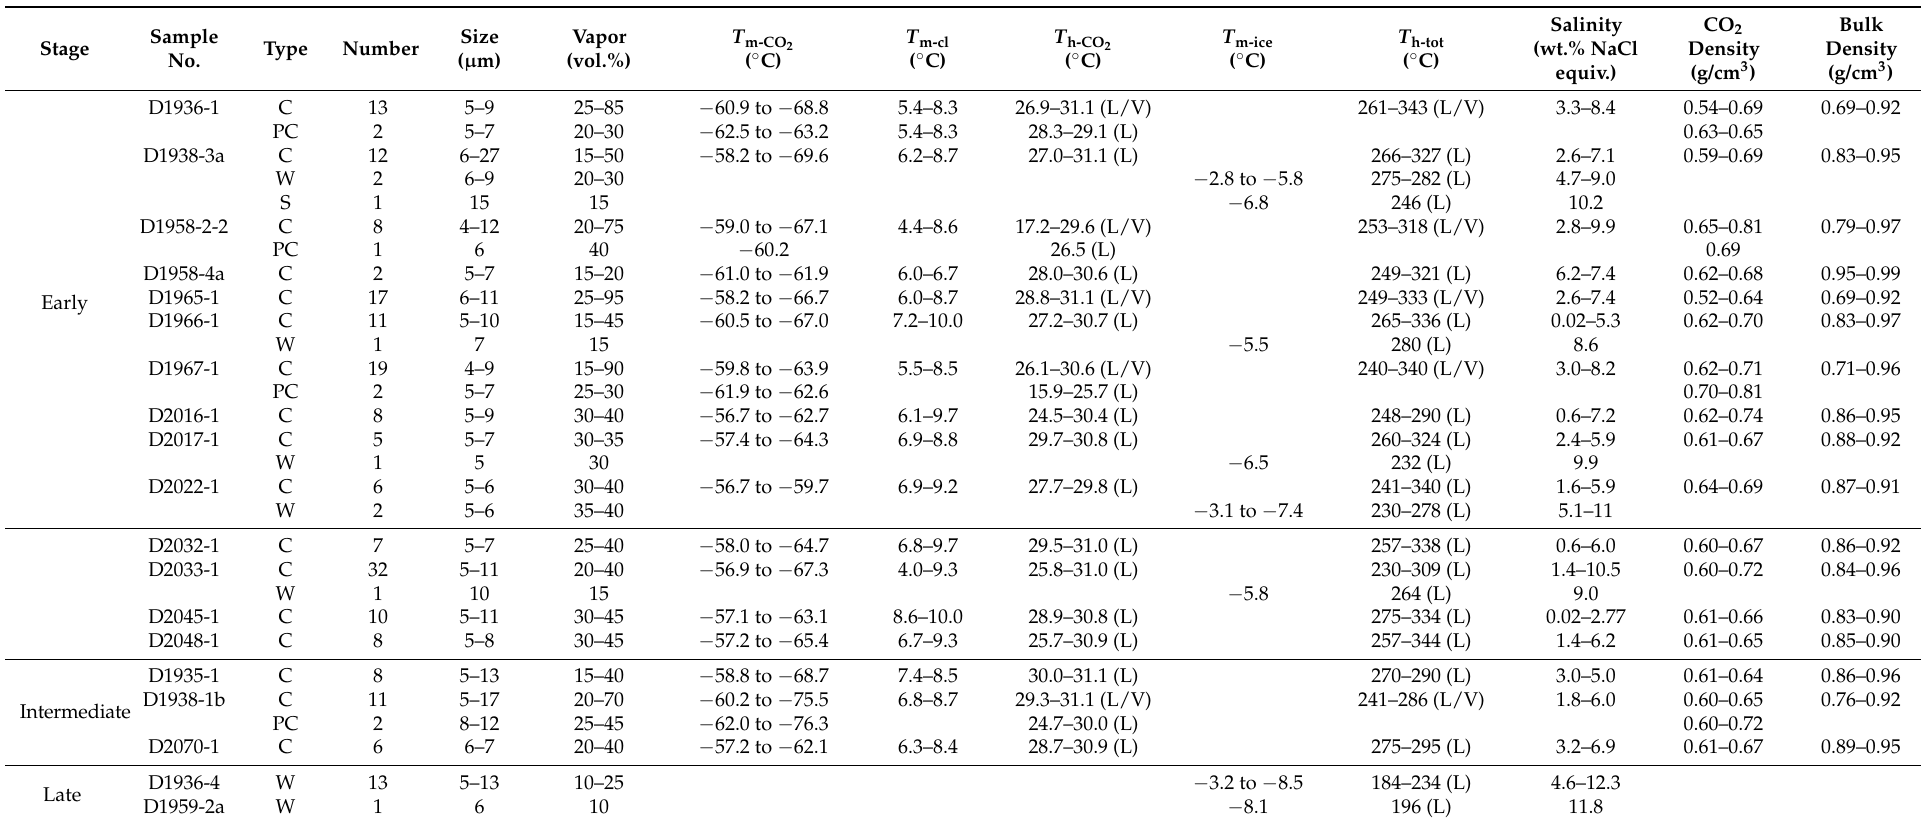
Table 1. Microthermometric data for fluid inclusions in quartz from the Juyuan tungsten